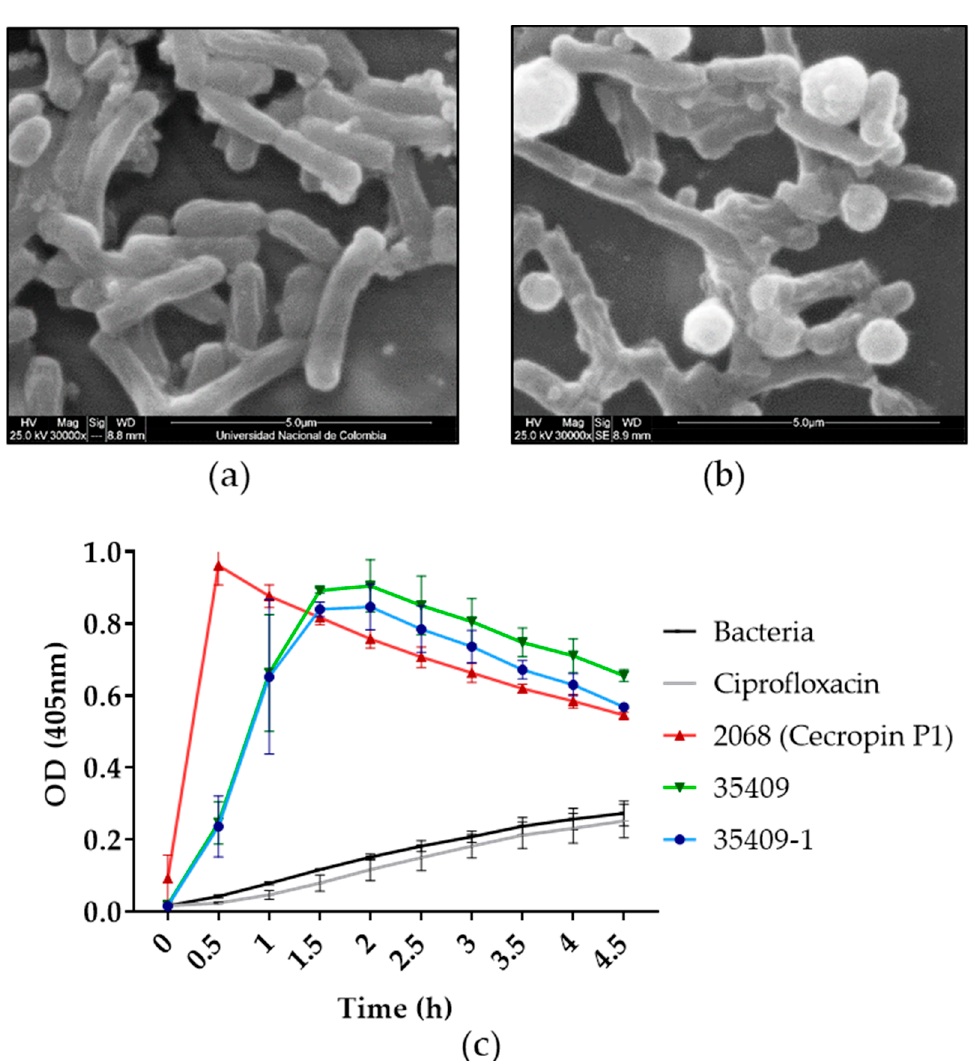
Figure 2. Peptide 35409-1 effect on E. coli membrane. Panels ( a , b ) show E. coli ATCC 25922, (a) without treatment and ( b ) treated with peptide 35409-1, by SEM. Panel ( c ) shows the permeabilisation of E. coli ML35 Gram-negative membrane evaluated with ONPG. The cecropin P1 peptide was used as positive permeabilisation control as it is recognised for its powerful membrane action. Untreated bacteria and ciprofloxacin-treated bacteria (an antibiotic having intracellular action) were used as negative controls.